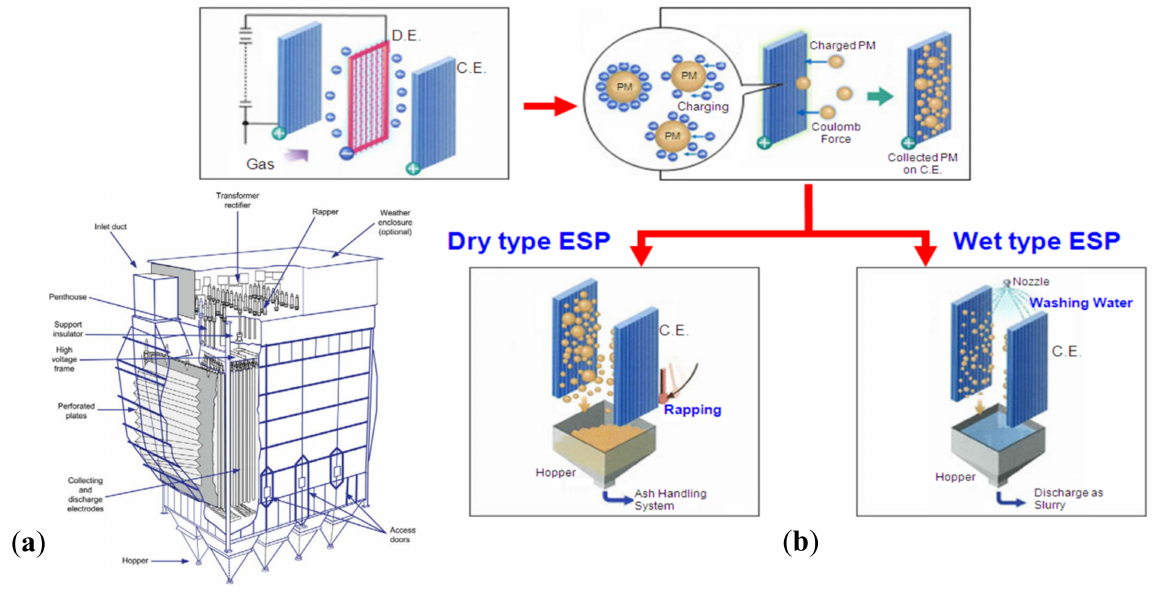
Figure 27. ( a ) Electrostatic precipitator; ( b ) operation mechanisms of WESP and DESP Adapted from Nagata et al.